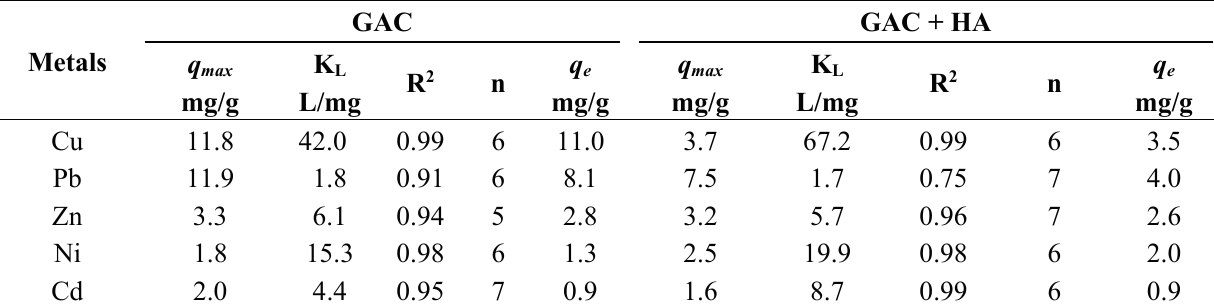
Table 1. Langmuir maximum adsorption capacity ( q max mg/g), coefficients of determination of Langmuir isotherm fit to data (R 2 ) and adsorption capacity at an equilibrium metal concentrations equivalent to the influent concentrations (Zn 1.80, Cu 0.99, Cd 0.11, Ni 0.12, Pb 1.03) used in column study ( q e mg/g) for heavy metal adsorption on GAC at pH